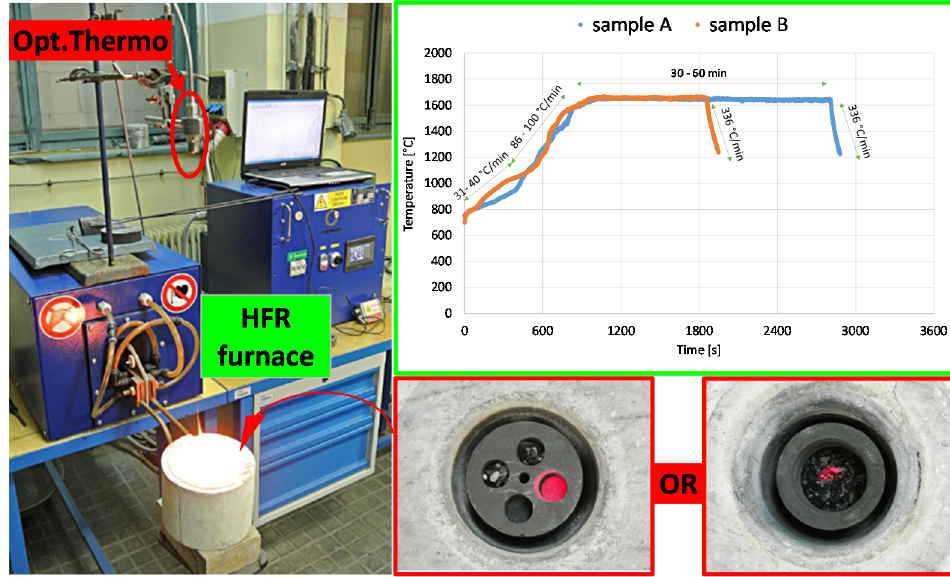
Figure 5. High temperature reducibility test